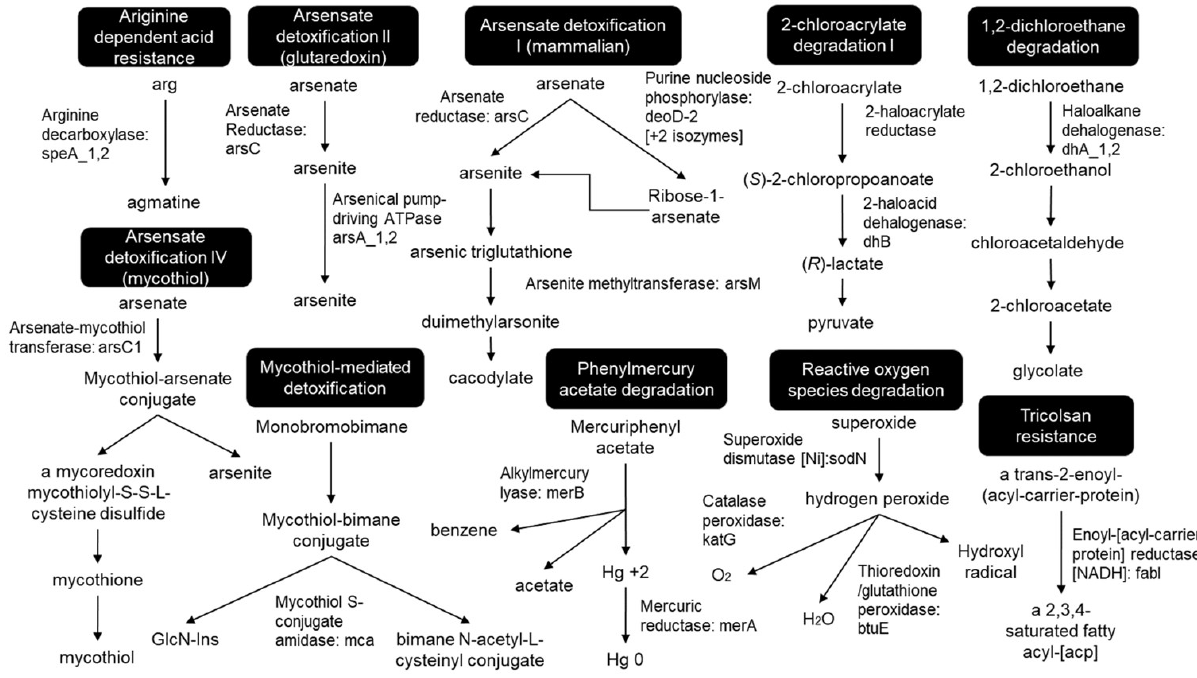
Figure 9. Detoxification pathways. The pathways have been redrawn from the pathway maps of all MAGs, provided in the